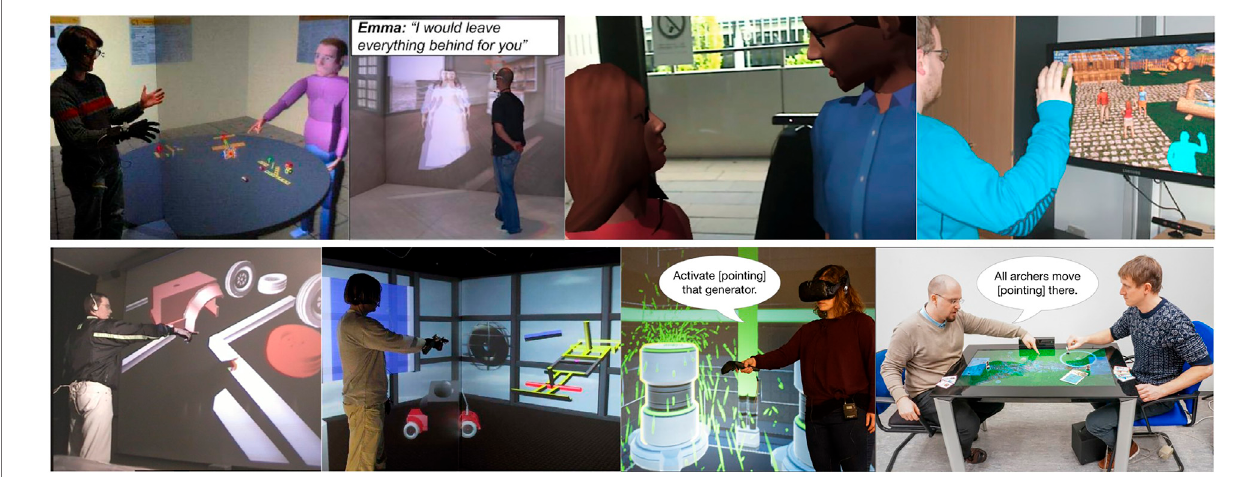
FIGURE 2 | Examples of XR-AI integrations. From upper left to lower right: A user is interacting with an intelligent virtual agent to solve a construction task (Latoschik, 2005) and interaction with an agent actor in Madam Bovary, an interactive intelligent story telling piece (Cavazza et al., 2007), both in a CAVE (Cruz-Neira et al., 1992); Virtual agents in an Augmented Reality (AR) (Obaid et al., 2012) and in a Mixed Reality (MR) (Kistler et al., 2012); Speech and gesture interaction in a virtual construction scenario in front of a power wall (Latoschik and Wachsmuth, 1998) and in a CAVE (Latoschik, 2005). Multimodal interactions in game-like scenarios full-immersed using a Head-Mounted Display (HMD) (Zimmerer et al., 2018b) and placed at an MR tabletop (Zimmerer et al., 2018a).